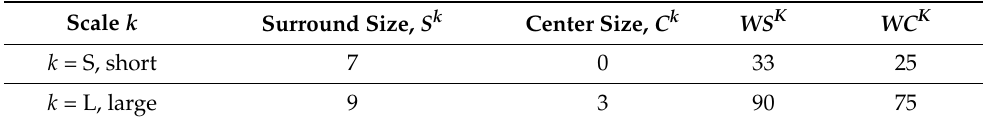
Table 2. Unoptimized values of HVS